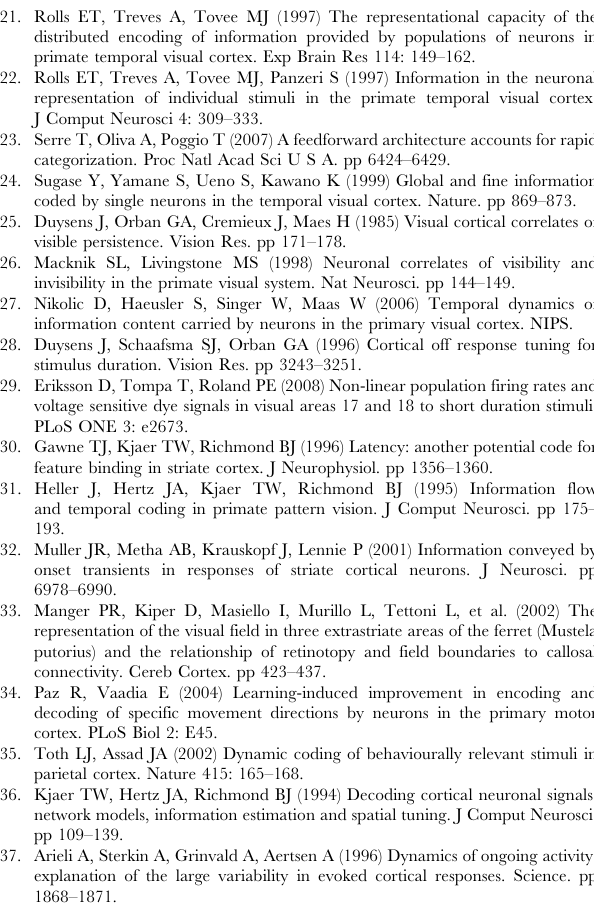
repeated over the stimulus monitor according to the same 8 6 8 grid. Figure S5 Dependency of temporal bin size. A: The correlation between decoded pattern and the previous and the current pattern for different temporal bins, 2, 5, 10, 25, 50ms. 0–250ms was used for estimating the average firing rate for the dictionary. B: The correlation with the current pattern was calculated using the average firing rate in a 2, 5, 10, 50 and 125 ms interval centered at 196 ms after the pattern to pattern transition, and the code was the average firing rate in a 2, 5, 10, 50 and 125 ms interval at 196 ms after the blank to pattern transition. Figure S6 The correlation with previous and current pattern is independent of pattern complexity. The decoding was done as a pattern was preceded by a blank screen (solid), and as a blank screen was preceded by a pattern (dashed). Figure S7 The Difference-Current-characteristics is evident for each cortical depth and cortical position. A: The decoding was done for four different cortical depths. B: The decoding was done within each penetration. Only penetrations that generated significant correlations are shown (each animal has its own color). C: Four penetrations were done within the same animal. D: Those four penetrations indicated by four yellow points on the operative field picture.